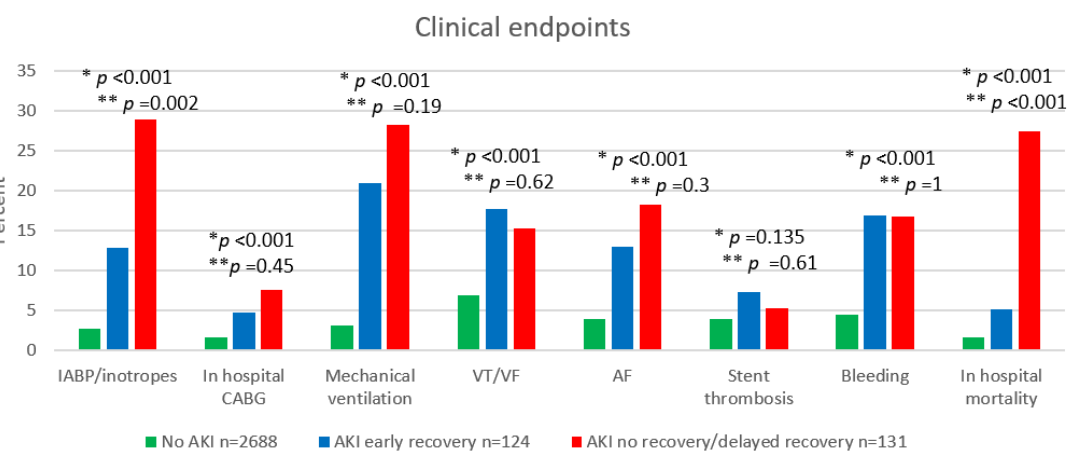
eGFR, estimated glomerular filtration rate; ER, emergency room.